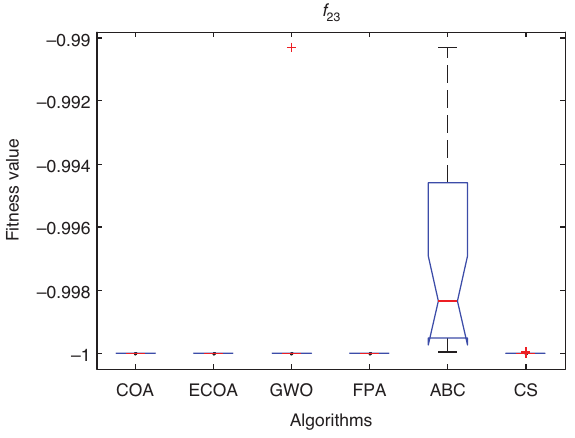
Figure 46: D = 2, ANOVA Test of Global Minimum for f